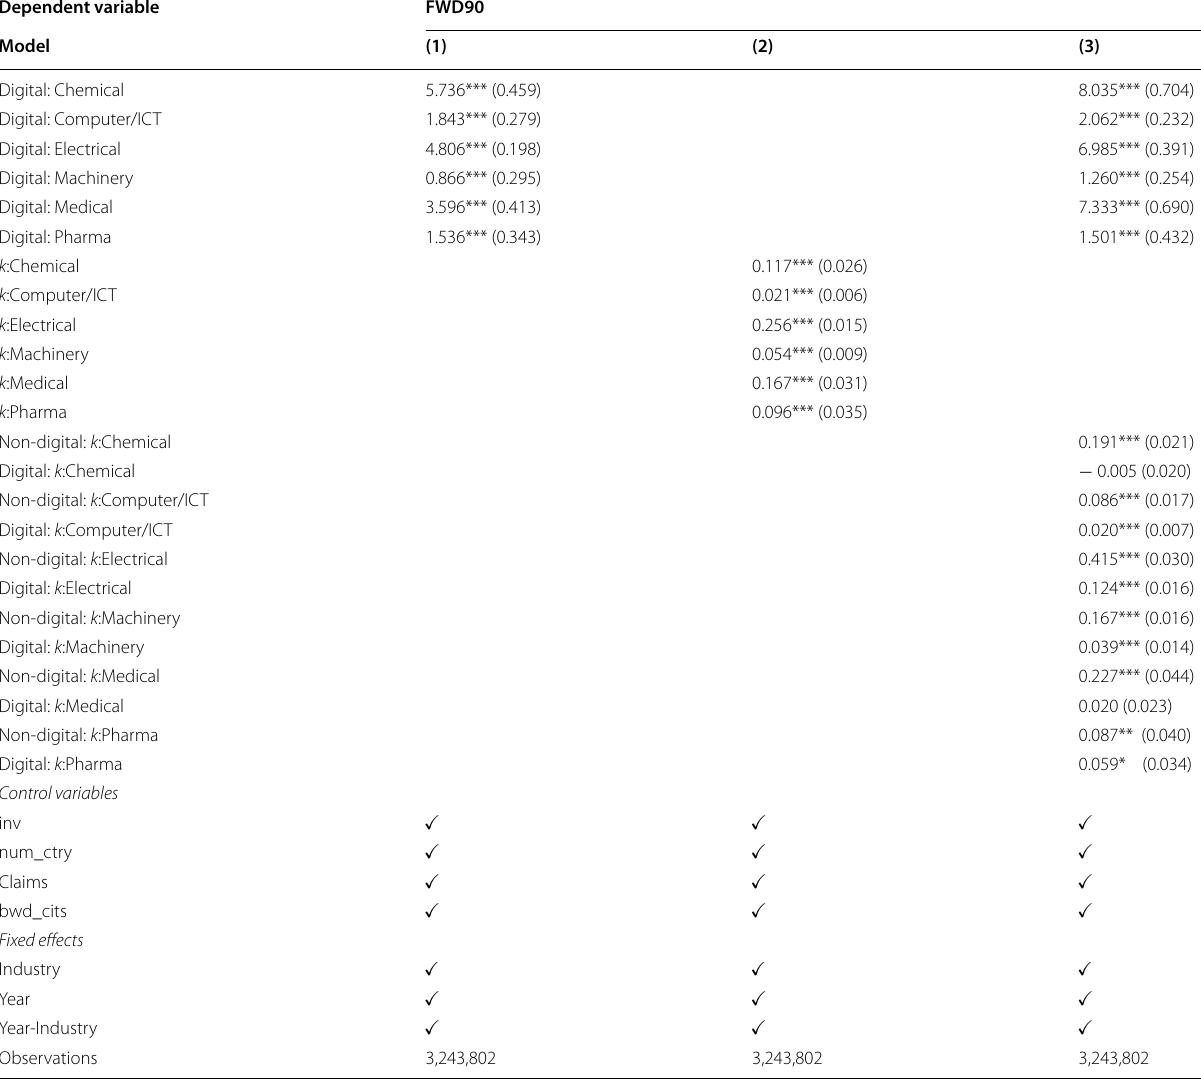
Table 2 Technological improvement rates and breakthrough innovations across